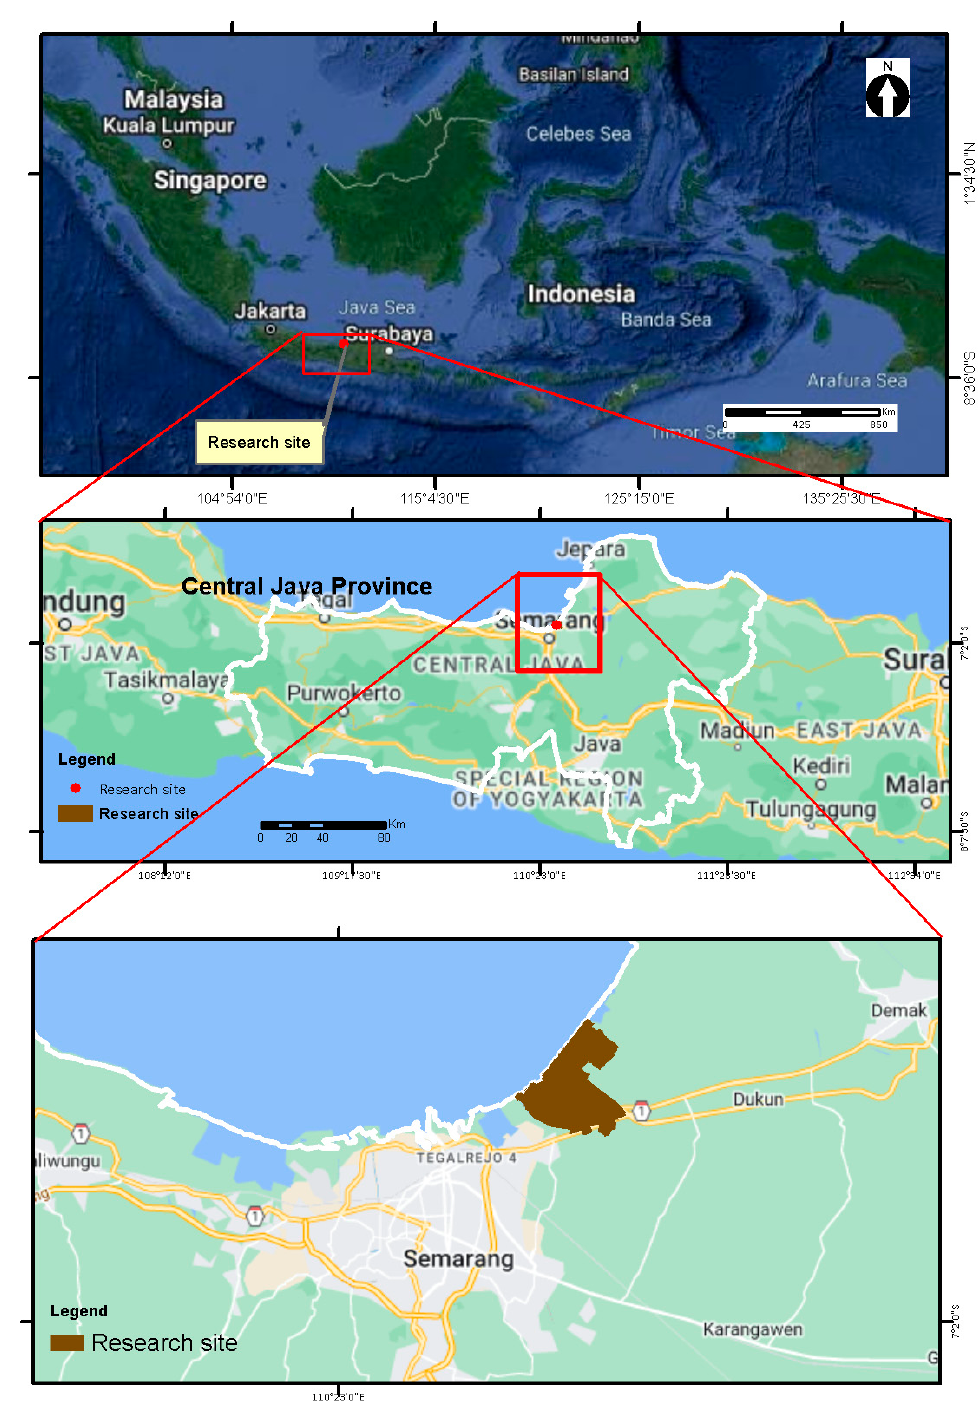
Figure 1. Location of the study area.